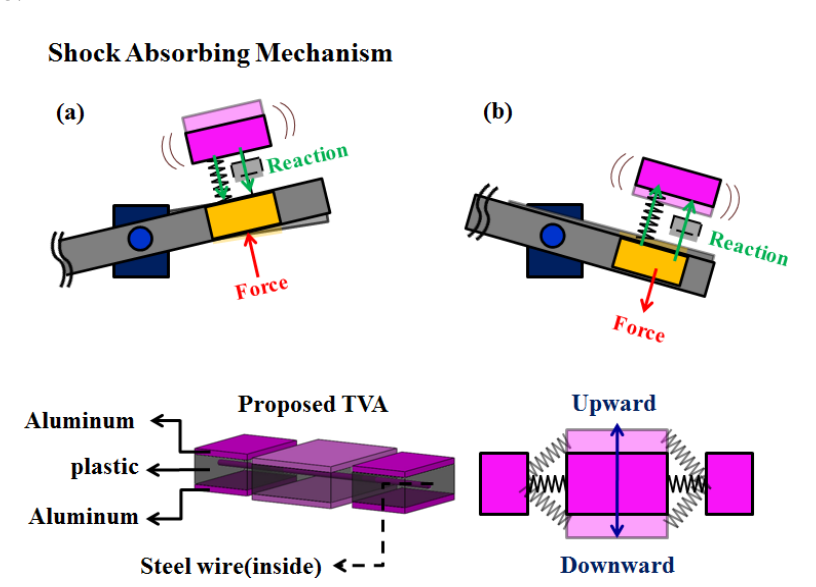
Figure 4. Developed tunable vibration absorber with system dynamics behavior: principles and